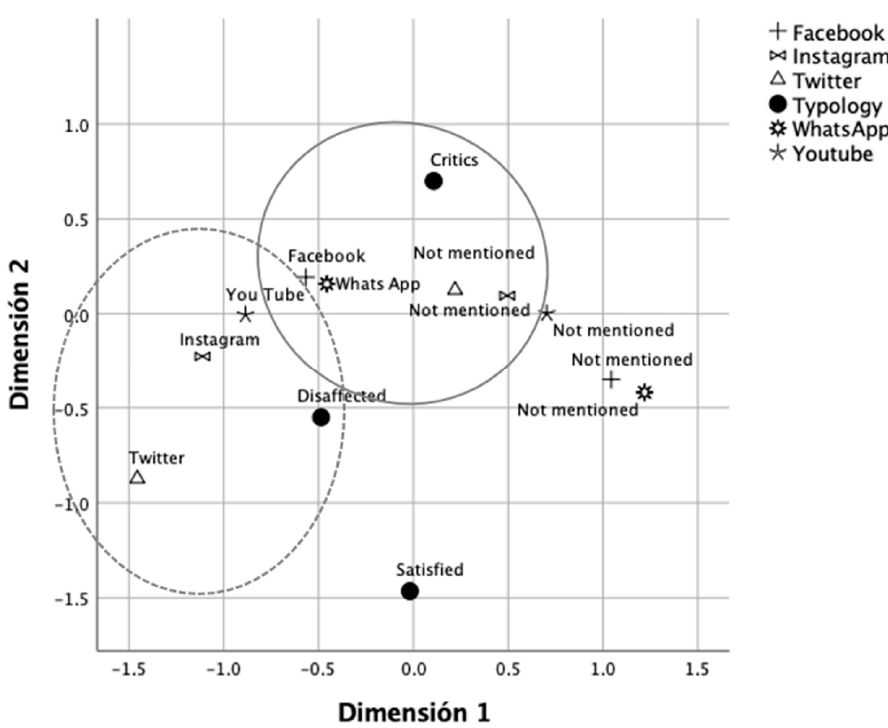
Figure 7. Social network following and citizen type. Source: Latinobarometer 2020. Figure 6. Social network following and citizen type. Source: Latinobarometer